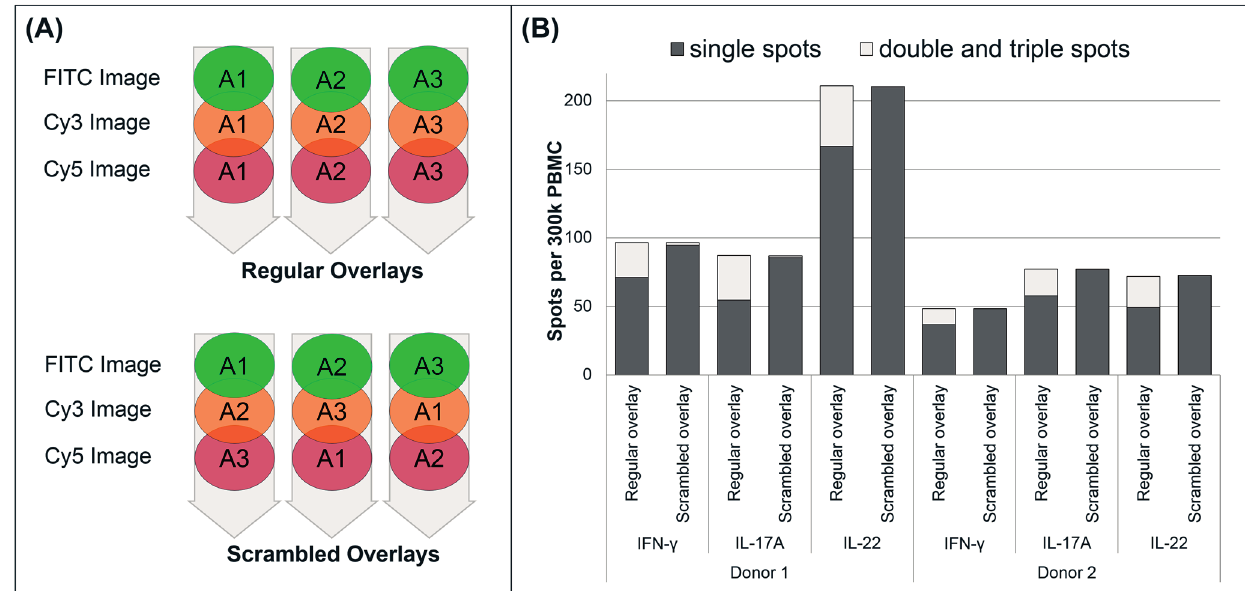
Figure 5. Scrambled analysis of triple FluoroSpot. ( A ) The regular overlay analysis of a well is made by comparing the location of spots on three images (one for each fluorophore) from one well. In the scrambled analysis, three images (each representing one fluorophore) from different wells within a triplicate were mismatched. Thus, one fluorophore image from well 1 was combined with another fluorophore image from well 2, a third fluorophore image from well 3, etc. ; ( B ) Example of two triplicates analyzed by a regular and scrambled overlay